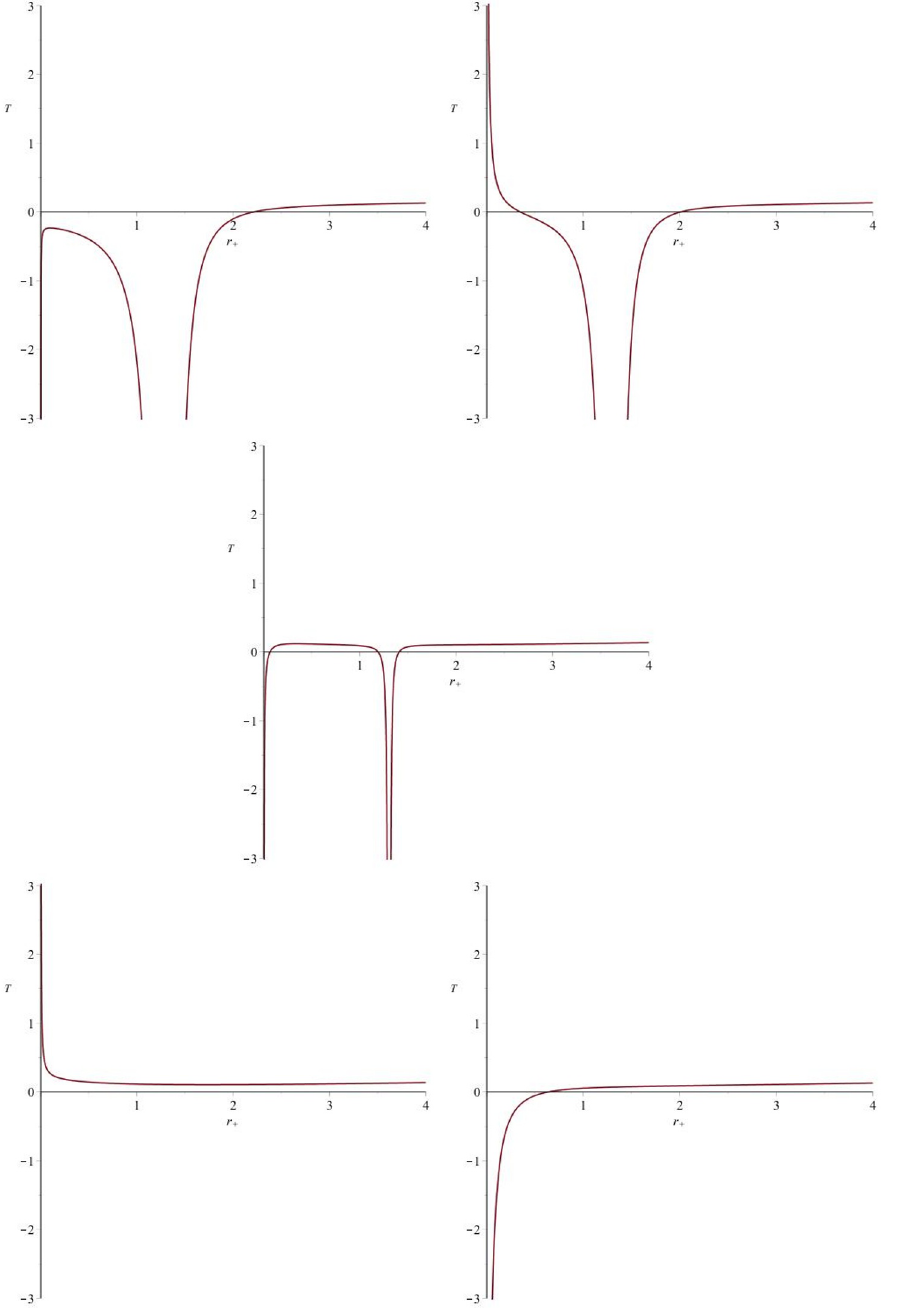
Figure 3 . Possible behaviours of the temperature for various values of the parameters, with ‘ = 3 . The upper three figures all have singularities at r + = n . The upper left figure has P t > P , with Q e = 1 , Q m = 1 . 3 and n = 1 . 3 . There is only one extremal black hole. The upper middle figure has P t < P , with Q e = 1 , Q m = 0 . 7 and n = 1 . 3 . There is both a large and a small extremal black hole. The upper right figure has P t > P , with Q e = − 1 . 1 , Q m = 1 . 3 and n = 1 . 3 . There is now a large extremal black hole and two smaller extremal black holes. The lower left figure has P t < P , with Q m = − Q e = − 1 . 1 , and n = 1 . 3 ; in this case there are no extremal black holes. The lower right figure has P t > P , with Q m = − Q e = − 1 . 4 , and n = 1 . 3 ; in this case there is one extremal black hole, but no singularity in T for r + > 0